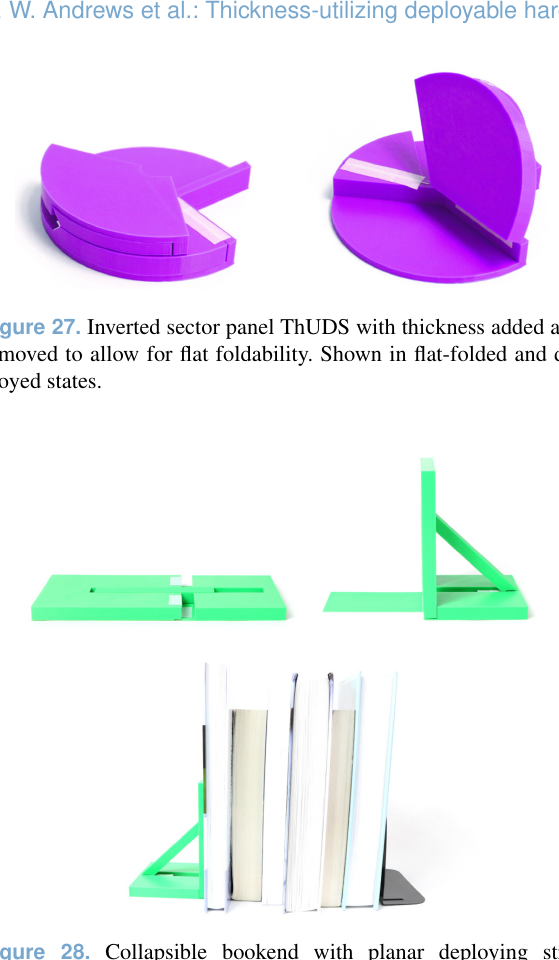
Figure 28. Collapsible bookend with planar deploying strut ThUDS. Shown in flat state, deployed state, and in functional use.